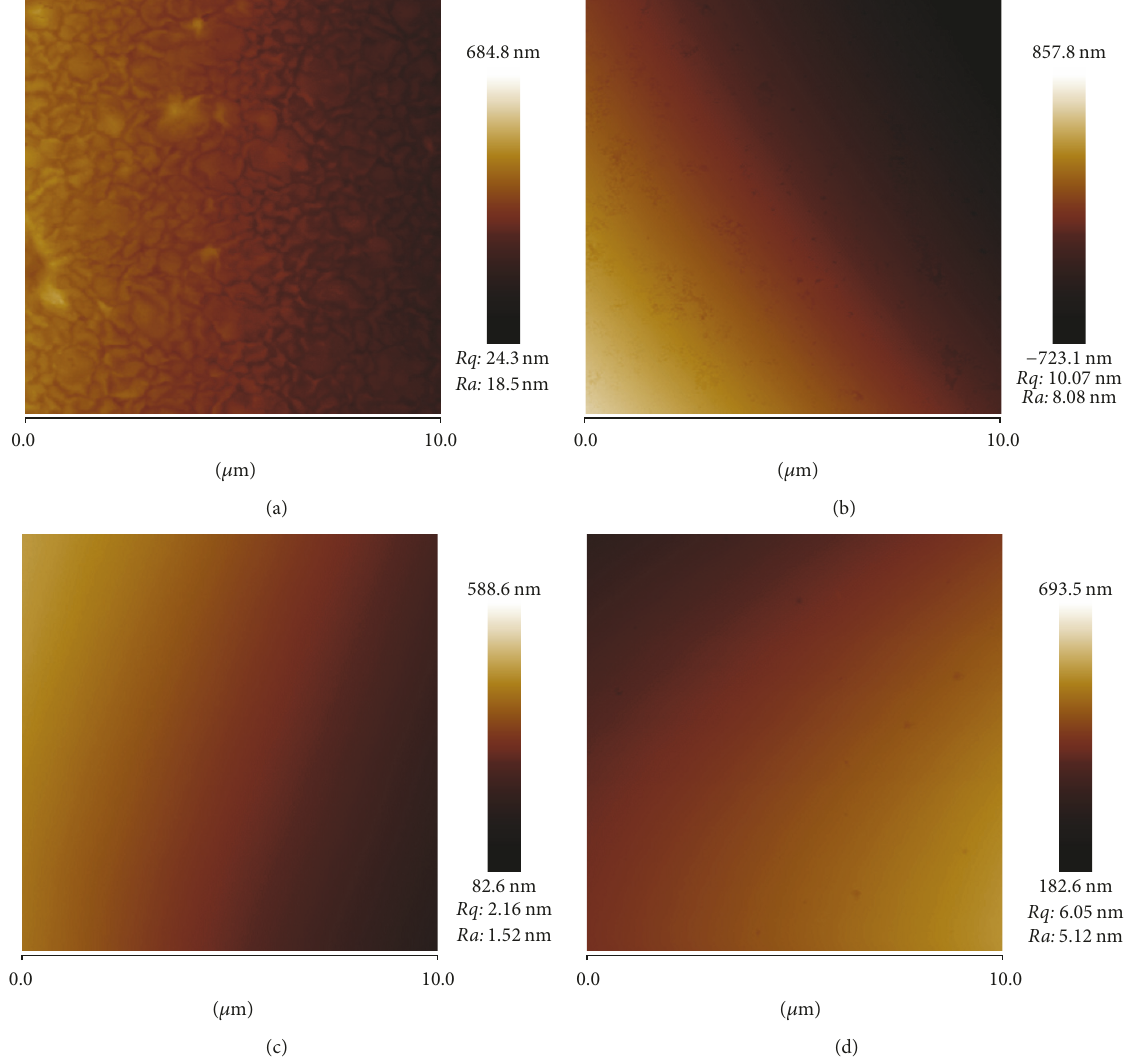
Figure 6: AFM images of the films: (a) SA film, (b) CS1, (c) CS2, and (d)